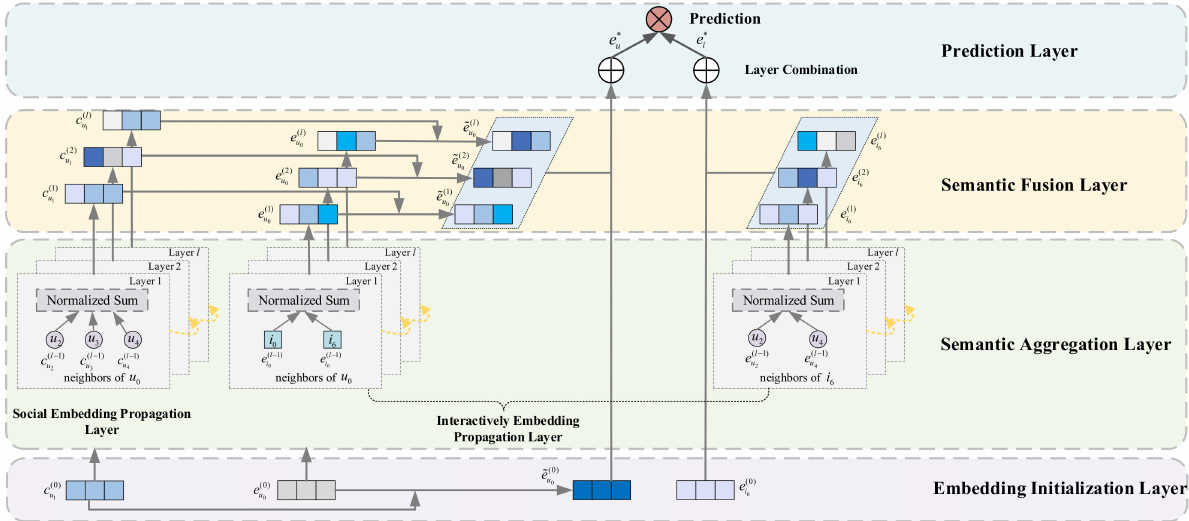
Figure 6. The overall frame structure of the proposed SRGCF